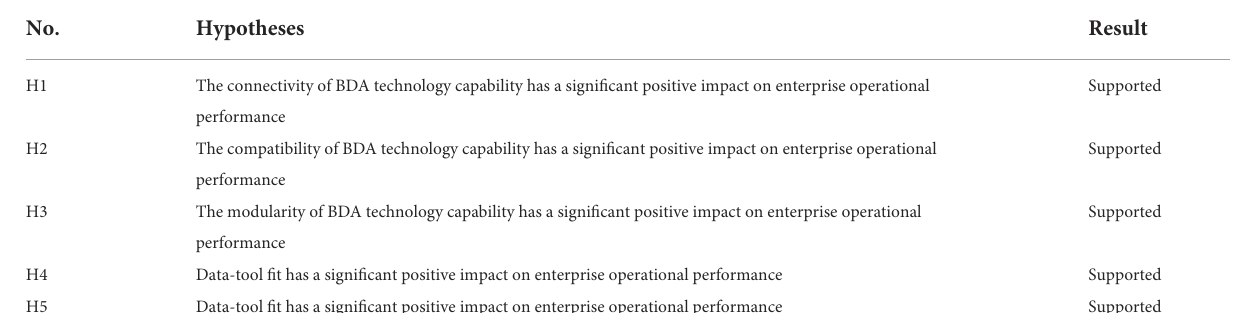
TABLE 10 Hypotheses test